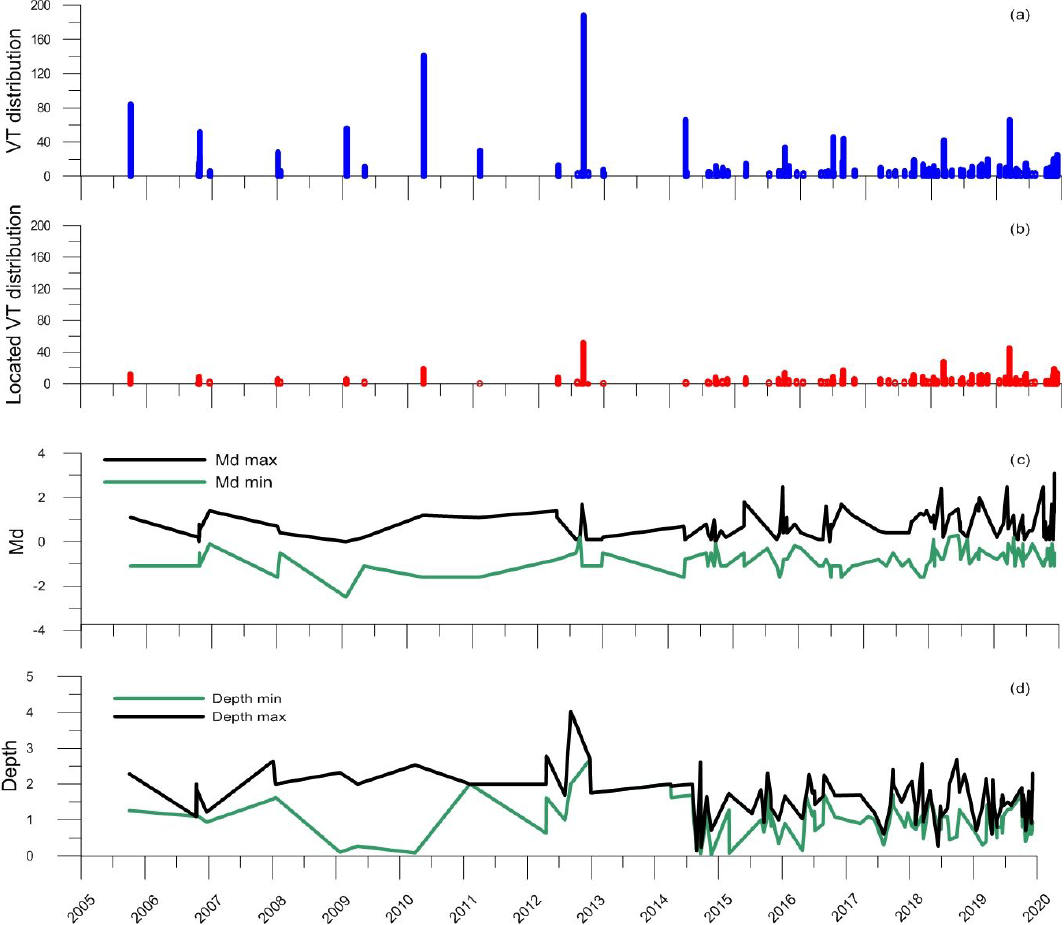
Figure 5. Some temporal properties of the CF-swarms extracted by GIS statistical tools between 2005 and 2019. (a) Distribution of the total number of VT earthquakes (blue) of each CF-swarm, and (b) Distribution over the time of the number of located VT earthquakes (red) of each CF-swarm. (c) max and min M d , and (d) max and min depth b.s.l. of each